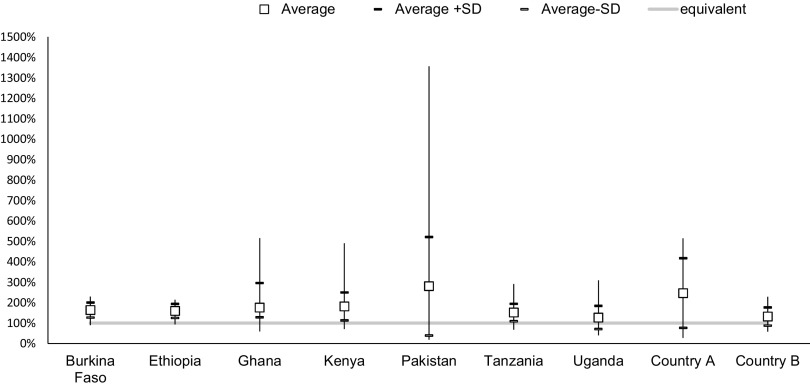
Inventory Needs in a Month as a Percentage of Consumption in the Same MonthAbbreviation: SD, standard deviation.